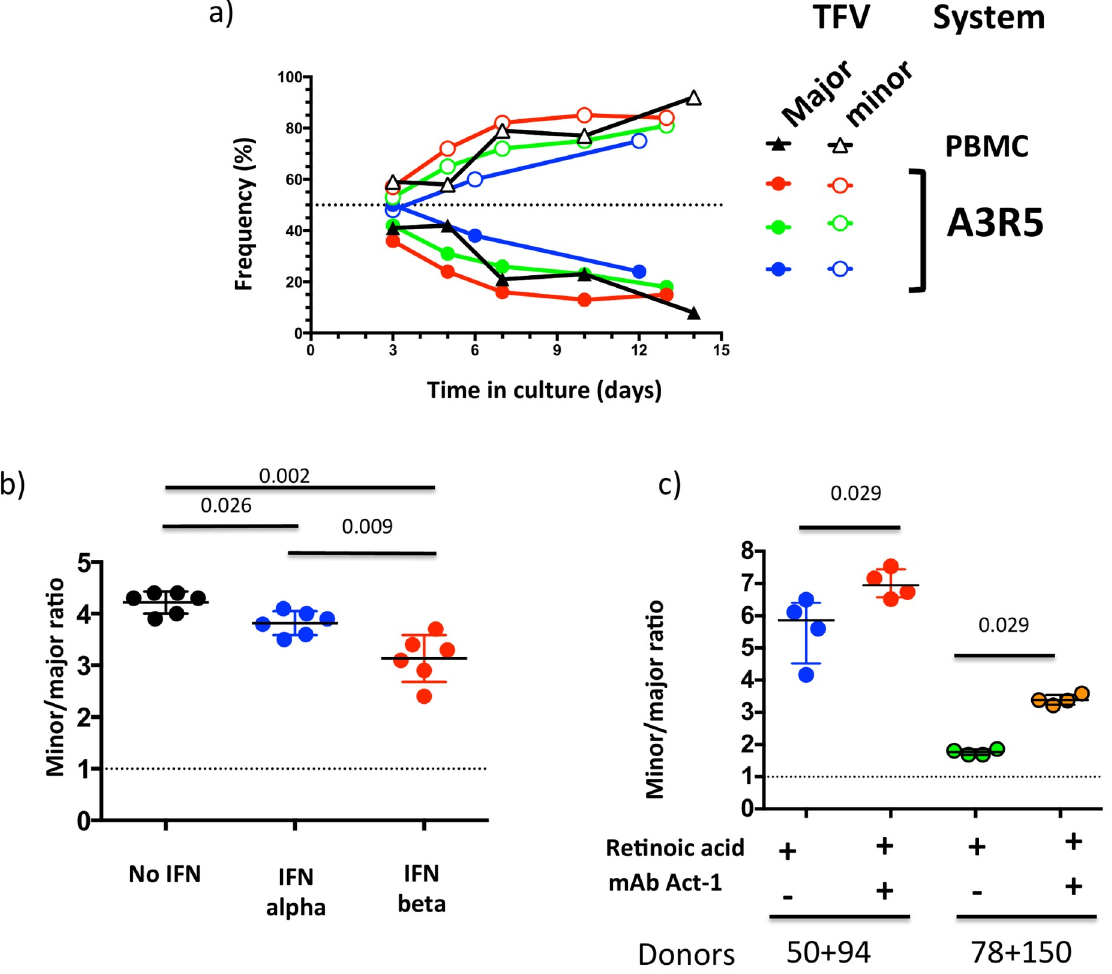
Fig 4. 40100 major and minor T/F viruses present distinct phenotypes in in vitro competition assays. a) The replication capacityof FLIMCs from 40100 major and minor T/F viruses was compared. Lines represent the proportionof infected cells that carried each T/F virus. Colors code for each experiment, which were conductedon PBMCs or the A3R5 cell line, as indicated. b) Ratio of cells infected with minor vs. major T/F virus after 6-day culture in PBMCs in control conditions (black), and in the presence of IFN alpha(blue) or IFN beta (red). c) Ratio of cells infected with minor vs. major T/F virus after 6-day culture in RA-treated PBMCs in the absence(blue, green) or presence(red, orange)of α 4 β 7-blocking mAb Act-1. Data for two different PBMC donor pools, 50+94 and 78+150,are shown. In all the experiments, the initial inoculumwas a 1:1 mixture of the two viruses (dotted lines). Whiskers represent interquartile intervals.